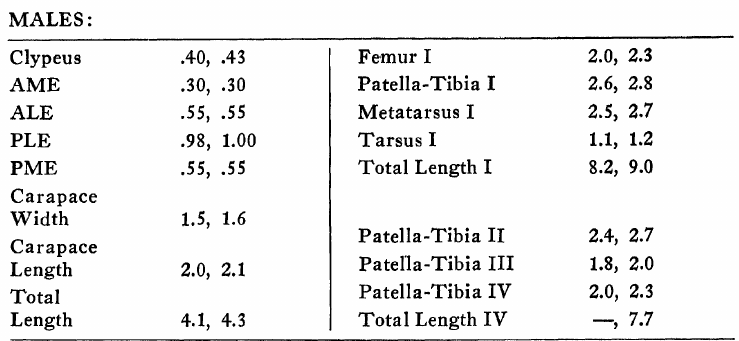
Color. Female. Face and chelicerte pale cream to yellow with vertical black stripes from AME to subdistal ends of chelicerae as in Figure 7. Eye nacelles black, ov’erlaid with white hair. Carapace pale yellow. Dorsum of abdomen white to cream with brown along sides as in Figure 8. Spinnerets pale yellow. Venter with broad cream colored stripe outlined with brown, extending rom epigastric furrow to base of spinnerets. Lateral areas white. Legs cream to pale yellow. Brown stripe on ventral surface of femora I and II in one specimen. Labium brown. Endites pale yellow. Sternum cream. Color. Male. Face and chelicerae pale yellow to yellow-orange. Black vertical stripes from AME to subdistal region of chelicerae as in Figure 63. Eye region black. Iridescent spatulate hairs be- tween P ME. Cymbia of palpi dark brown to black. Carapace yellow to yellow-orange. Some purplish iridescence in one male. Dorsum of abdomen with cardiac area translucent gray, sur- rounded by white pigment with lateral areas dark brown to black as in Figure 64. Other male with dorsum entirely black. Venter with dark patch over genital area. Dark median stripe from epi- gastric furrow to base of spinnerets. Spinnerets yellow. Other male with renter entirely black. Legs yellow. Faint stripe on ventral surface of femur I in one